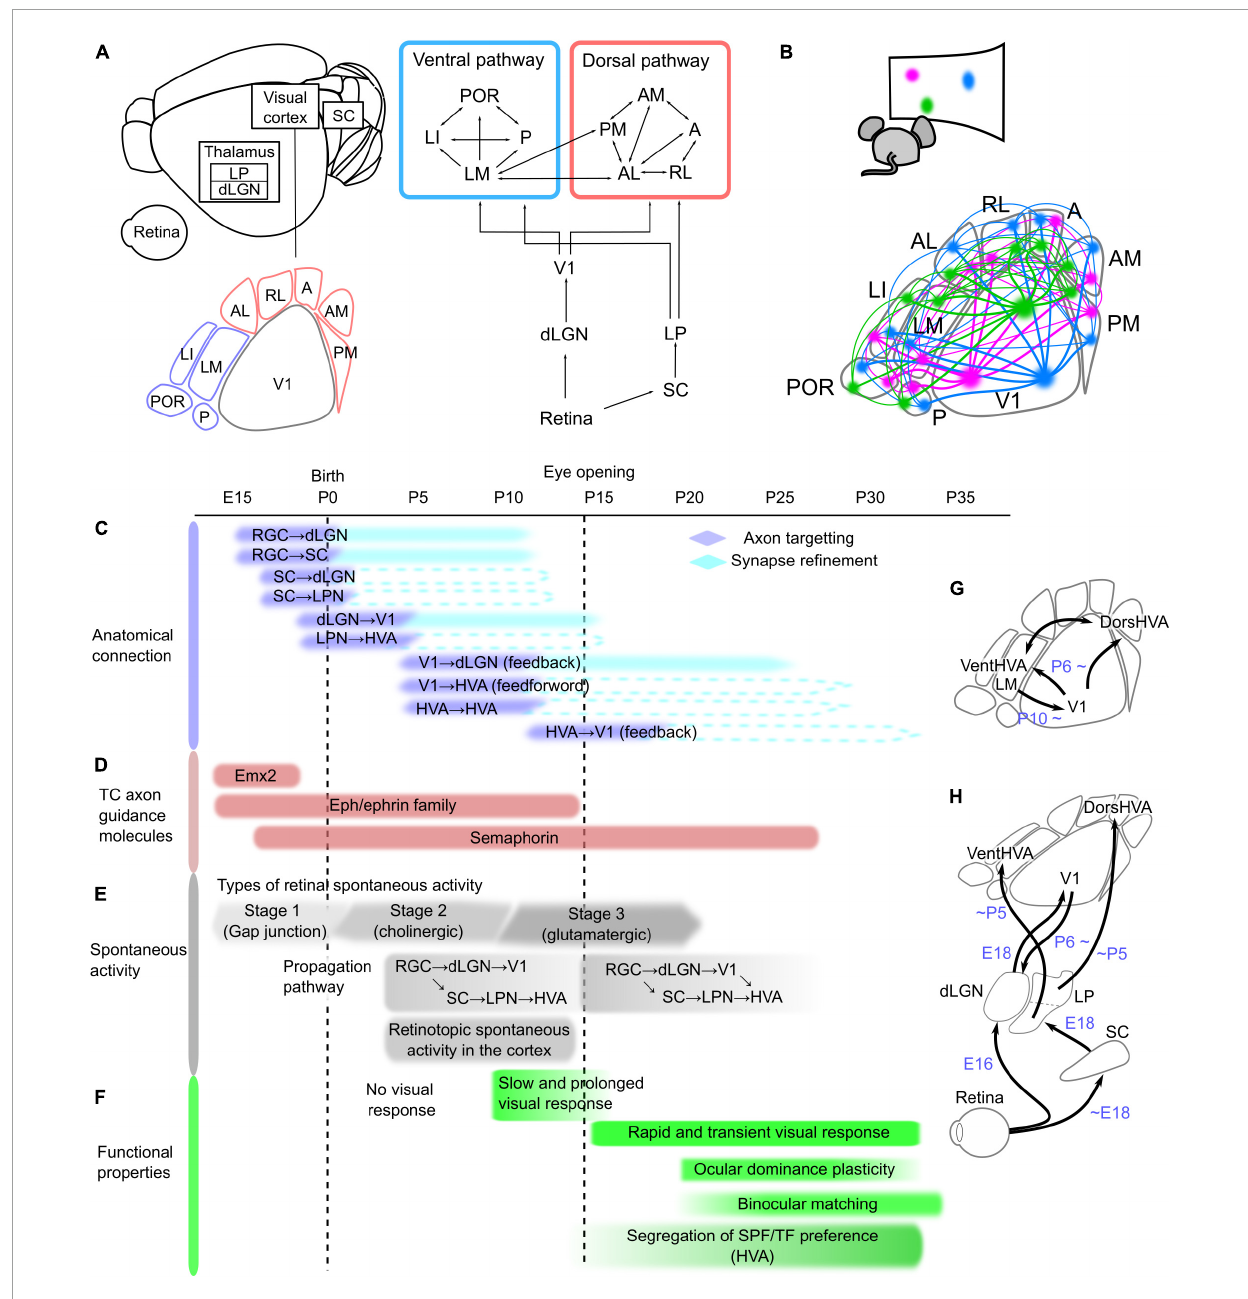
FIGURE1 Network structure and developmental timeline of the mouse visual system. (A) Schematic of the neural network in the mouse visual system, which is composed of the retina, dorsal lateral geniculate thalamic nucleus (dLGN), superior colliculus (SC), lateral posterior thalamic nucleus (LPN), and visual cortex, including the primary (V1) and higher-order visual areas (HVAs). These areas are connected hierarchically. The retina sends projections to the dLGN and SC, and these regions send projections to V1 and the LPN, respectively. At least nine HVAs surround V1 in the mouse brain. HVAs receive visual information through the dLGN–V1 or SC–LPN pathway. HVAs are categorized into dorsal and ventral pathways, and the connections between HVAs belonging to the same pathway are stronger than those across pathways. (B) Corticocortical connections among V1 and HVAs maintain the information of object positions in the visual field, which is retinotopy. The colors in the bottom figure correspond to the locations in the visual field shown above, and the same color regions of V1 and HVAs are connected. Developmental timeline of the mouse visual system in terms of anatomical connections (C) , expression of thalamocortical (TC) axon guidance molecules (D) , spontaneous activity (E) , and functional properties of neurons in V1 and HVAs (F) . The right schematics (G,H) illustrate the timing of axon targeting for each areal pair. (C) Axonal projections reach the target area and undergo refinement to the synapse in the precise area. The timing of the formation of axon projections from the retina to V1 and of corticocortical connections between V1 and HVAs has been elucidated, and the process of synapse refinement has also been demonstrated in the pathways from the retina to the dLGN and SC, and from the dLGN to V1 (shown as filled boxes). However, it is not yet known whether the pathways from the SC to the dLGN or LPN, from the LPN to HVAs, and the connections between V1 and HVAs undergo synapse refinement (indicated by dashed lines). (D) Timing of expression of representative axon guidance molecule families that form thalamocortical projections from the dLGN to V1. Eph/ephrin and semaphorin families have many subtypes that are expressed at different developmental stages, and they are all shown together in this figure. (E) Retinal activity during development is classified into three types that are mediated by different forms of neurotransmission.